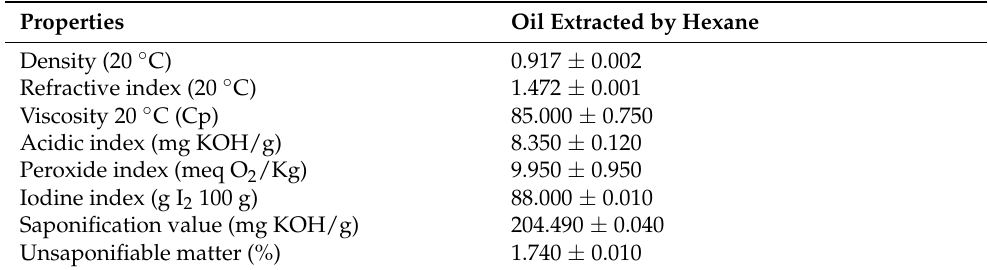
Table 1. Physico-chemical proprieties of oil P. atlantica seeds: according to Achheb et al. [116].